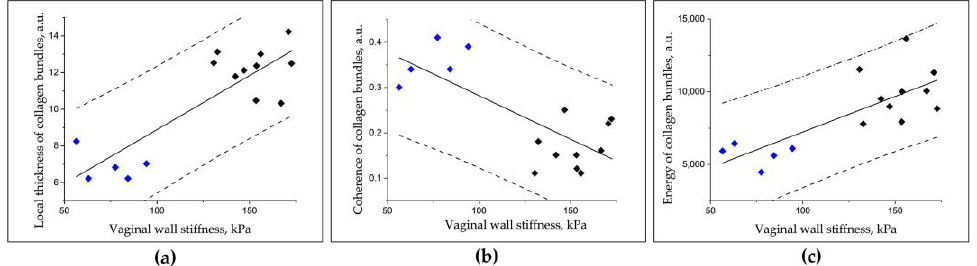
Figure 6. Relation between stiffness according to C-OCE data and collagen bundles structure pa- rameters according to histology data in the vaginal wall with stage I – II prolapse (blue squares) and stage I – II prolapse after a course of Nd:YAG laser treatment (black squares). ( a ) High positive correlation is demonstrated between vaginal wall stiffness and local thickness of the collagen bundles (r = 0.668, p = 0.006). ( b ) An inverse relationship is demonstrated between vaginal wall stiffness and coherence parameter of the collagen bundles ( r = −0 .568, p = 0.027). ( c ) High positive correlation is demonstrated between vaginal wall stiffness and the energy parameter of the collagen bundles (r = 0.714, p = 0.003). The dotted lines show 95% prediction intervals.